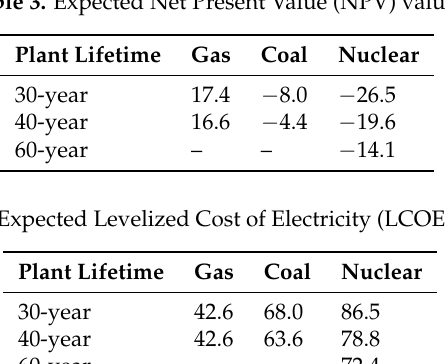
Table 3. Expected Net Present Value (NPV) values.